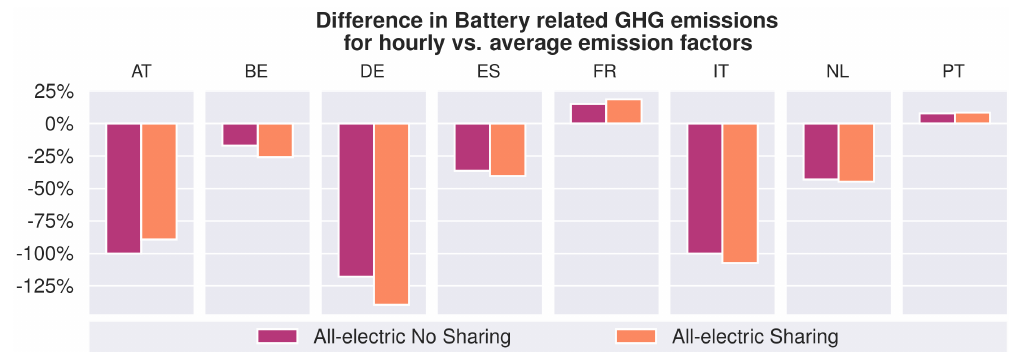
Figure 11. Difference between GHG emissions calculated using hourly emission factors vs. average emissions factors for battery usage. Positive bars indicate that with HEFs, the emissions are higher.The results presented here only include the emissions related to charging and discharging of the battery, to highlight the effects of using HEFs vs.